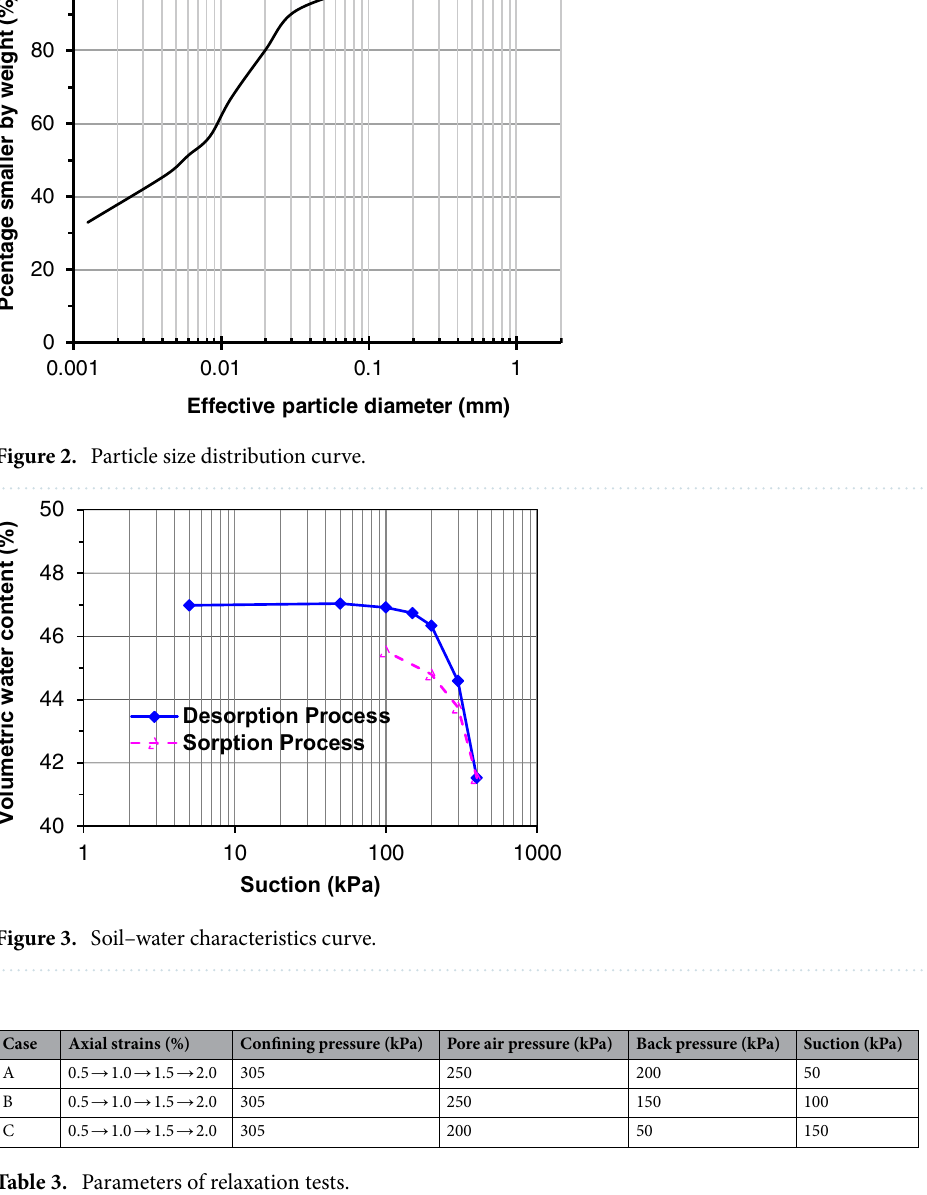
Table 3. Parameters of relaxation